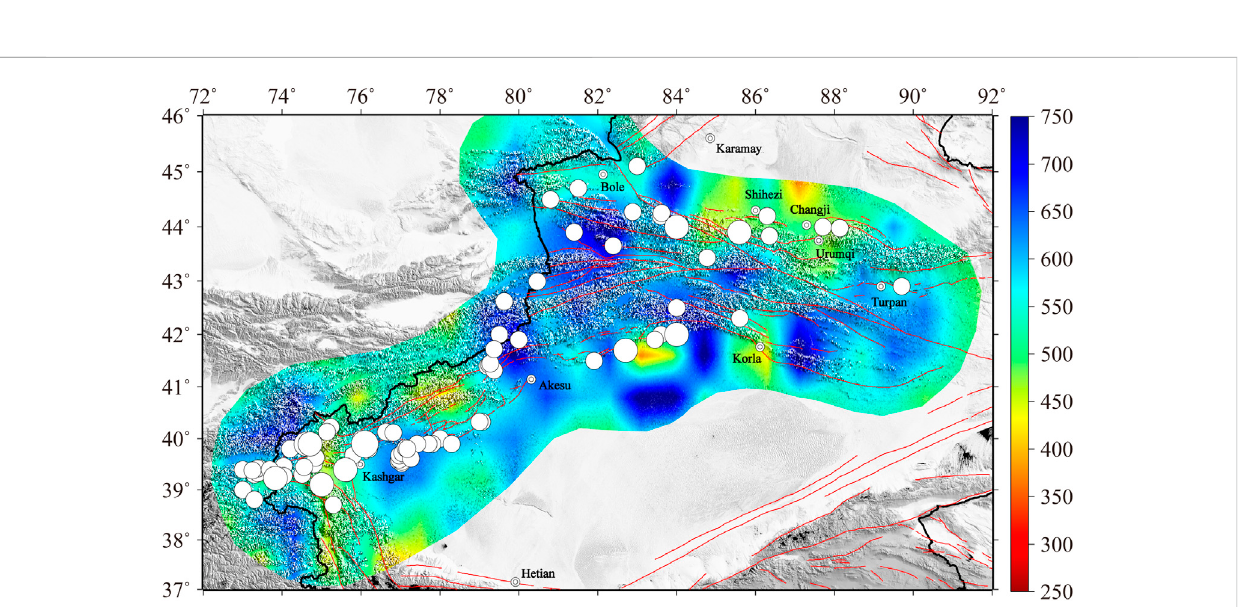
Frontiers in Earth